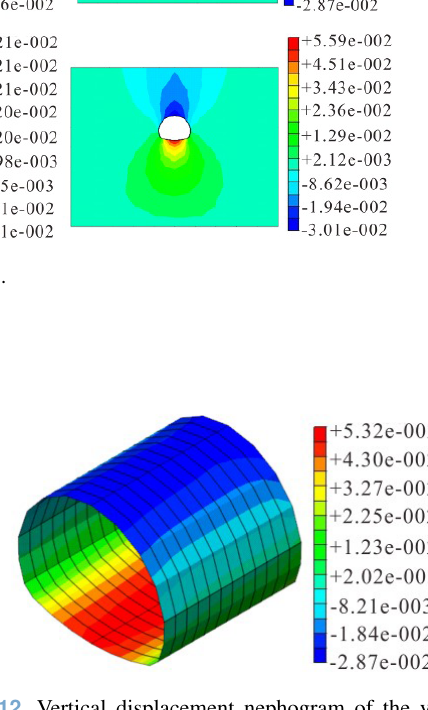
Figure 12. Vertical displacement nephogram of the vault under Condition 1 (mm).